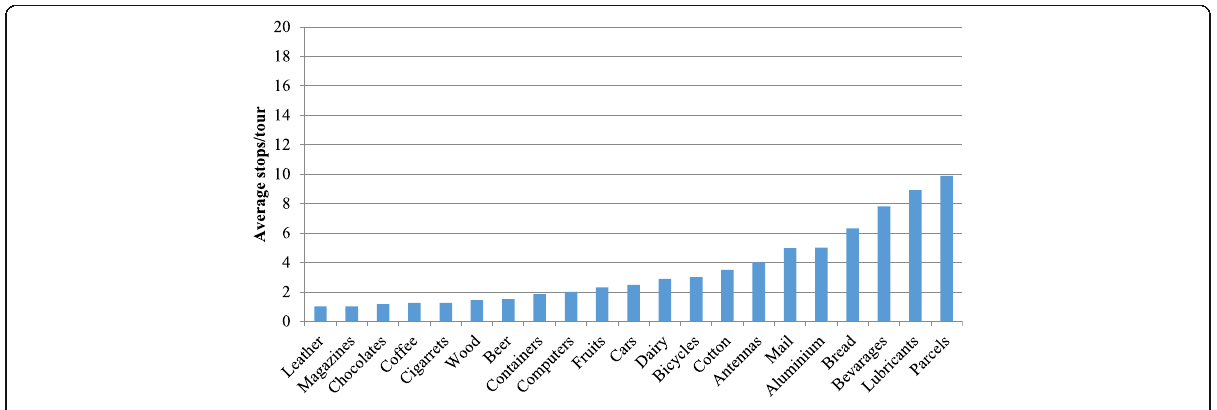
Fig. 2 Average number of stops per commodity